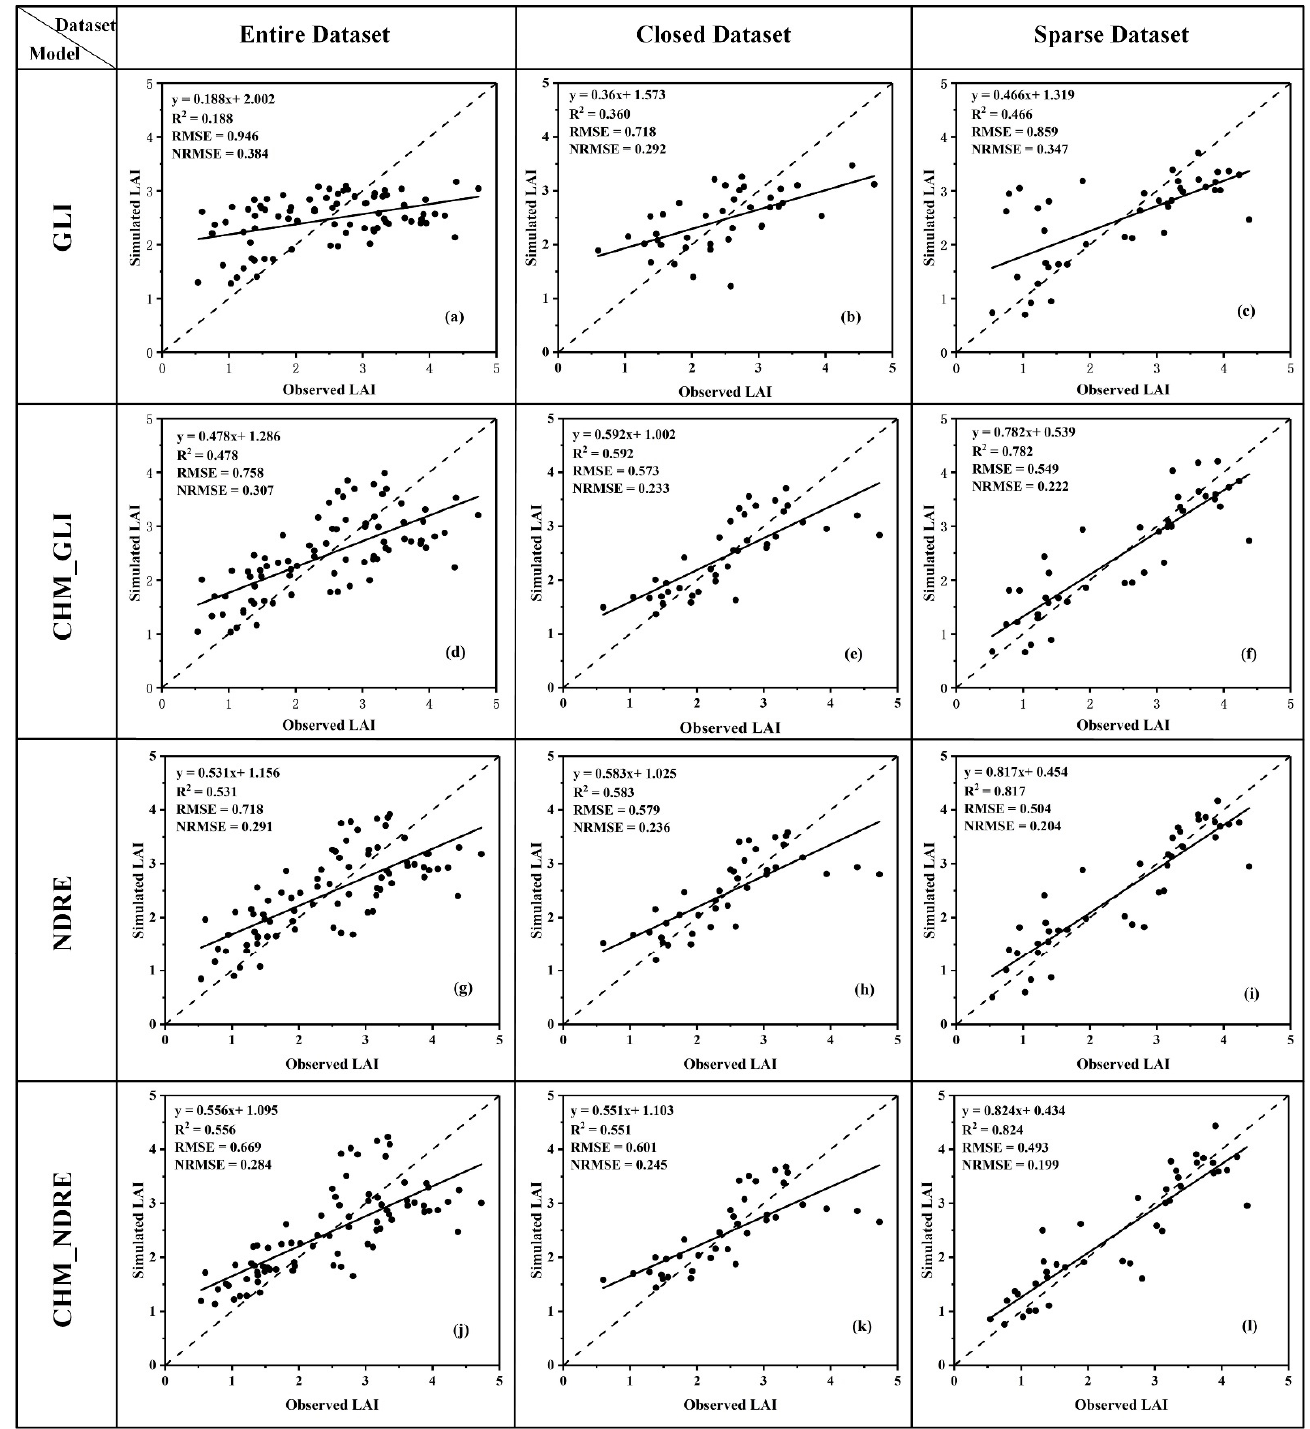
Figure 6. Estimation performances of four models with the entire, closed, and sparse dataset. ( a – f ) shown the estimation performances of GLI and CHM_GLI on entire, closed and sparse dataset respectively; ( g – l ) shown the estimation performances of NDRE and CHM_NDRE on entire, closed and sparse dataset